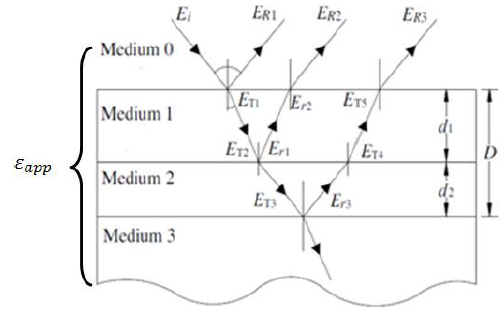
Figure 1: Studied surface